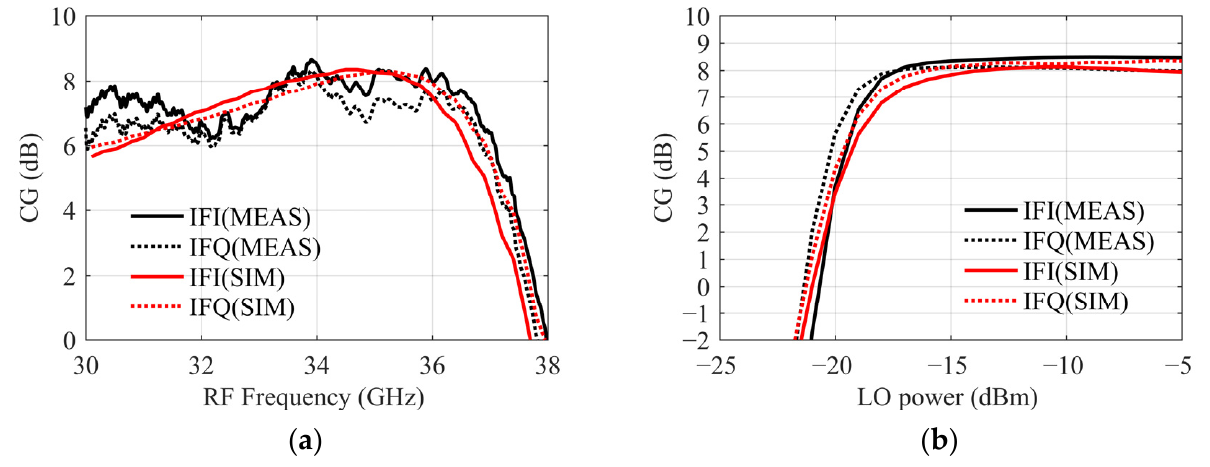
Figure 20. ( a ) I/Q conversion gain varies with RF frequency. ( b ) I/Q conversion gain varies with LO power.